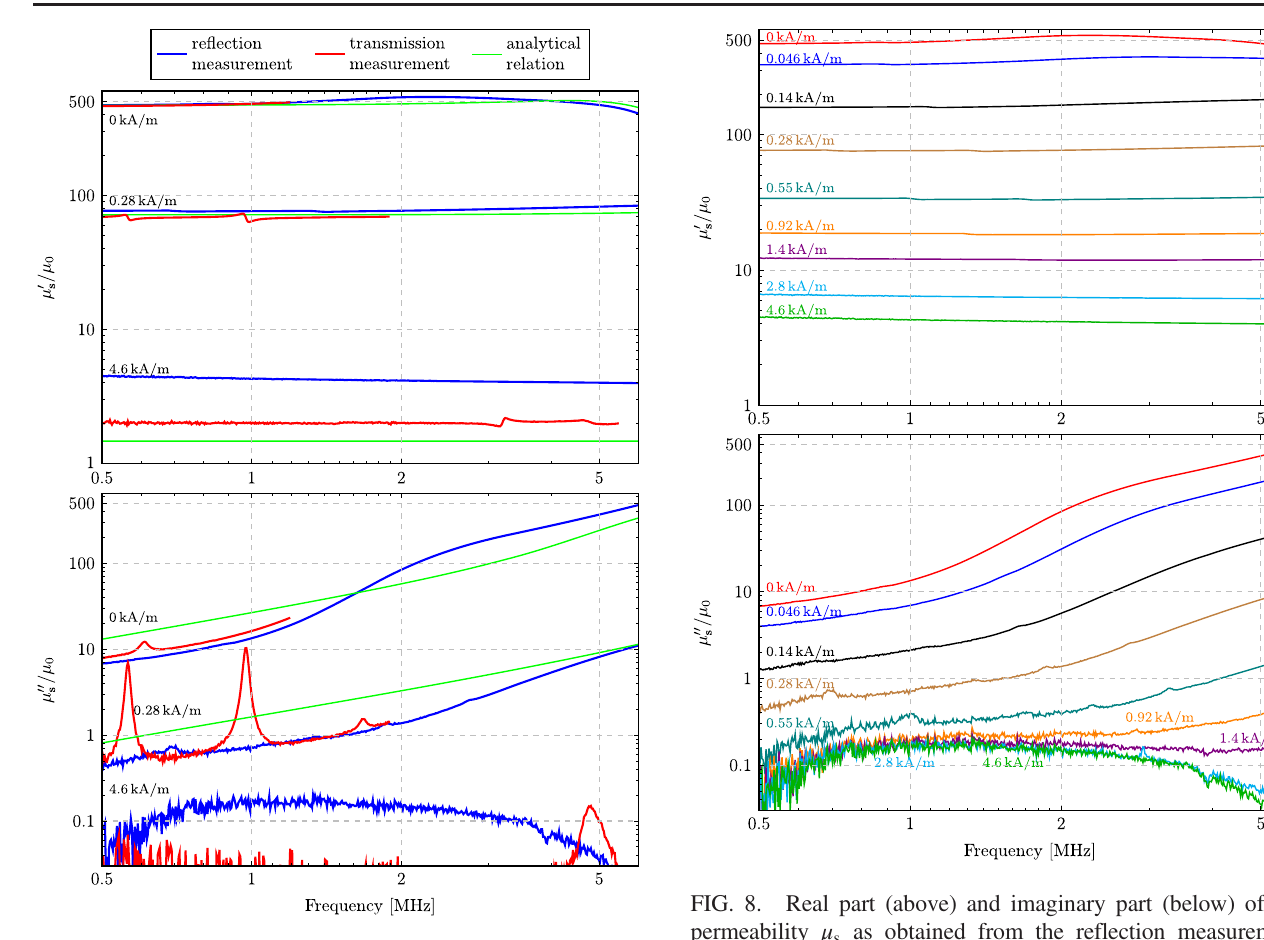
and μ 00 are plotted in Fig. 7 for three selected bias field s s